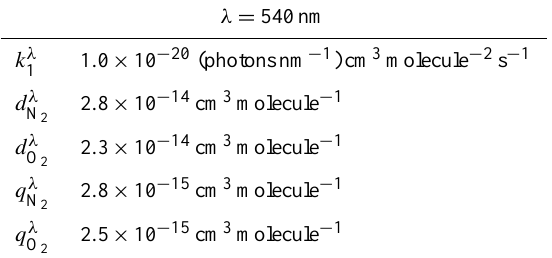
Table 1. Adopted parameters used in Eq. (4) for calculating k λ , the total bimolecular rate coefficient for the NO 2